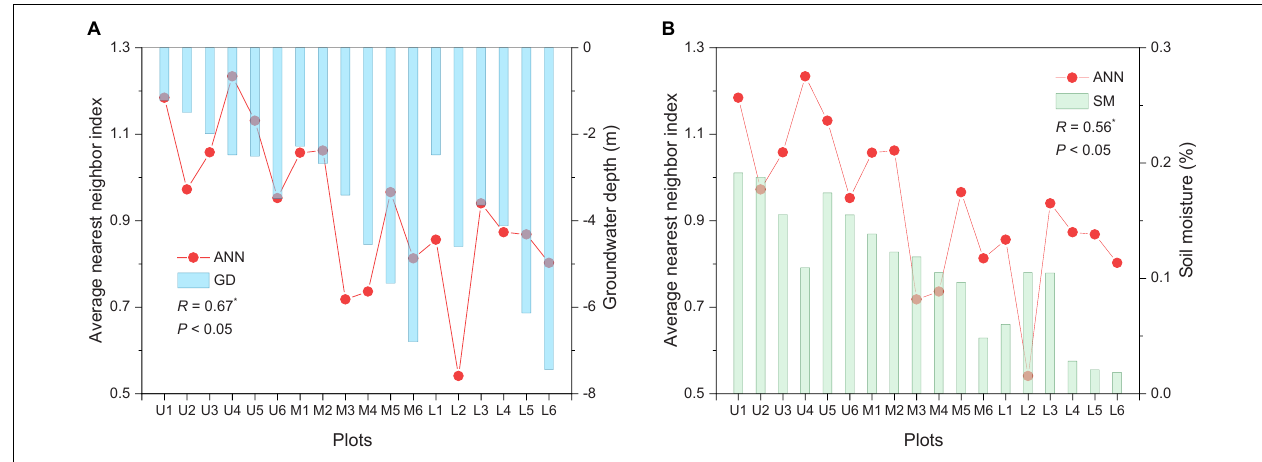
R represented random pattern; U represented uniform/regular pattern; A represented aggregated pattern.** was significantly correlated at 0.01 level; * significantly correlated at 0.05 level.